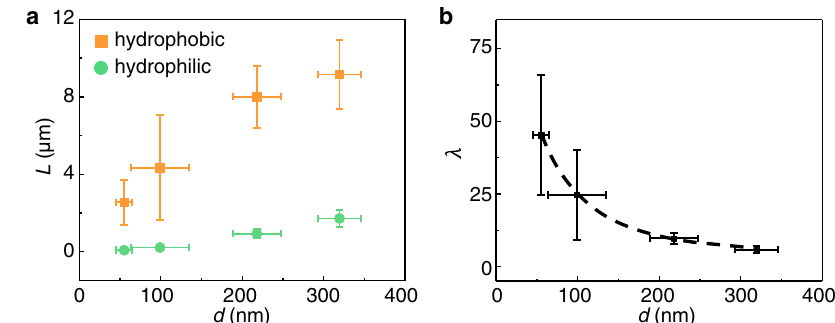
Fig. 2 | Nanochannel size dependent creep fl ow of Bi. a Measured length of Bi nanowires versus cavity size, where the Bi nanowires were molded by using AAO nanomolds with cavity size of ~55, 100, 220 and 320nm, respectively. The loading pressure was increased from zero to 300MPa with a loading rate of 3MPa/s. The